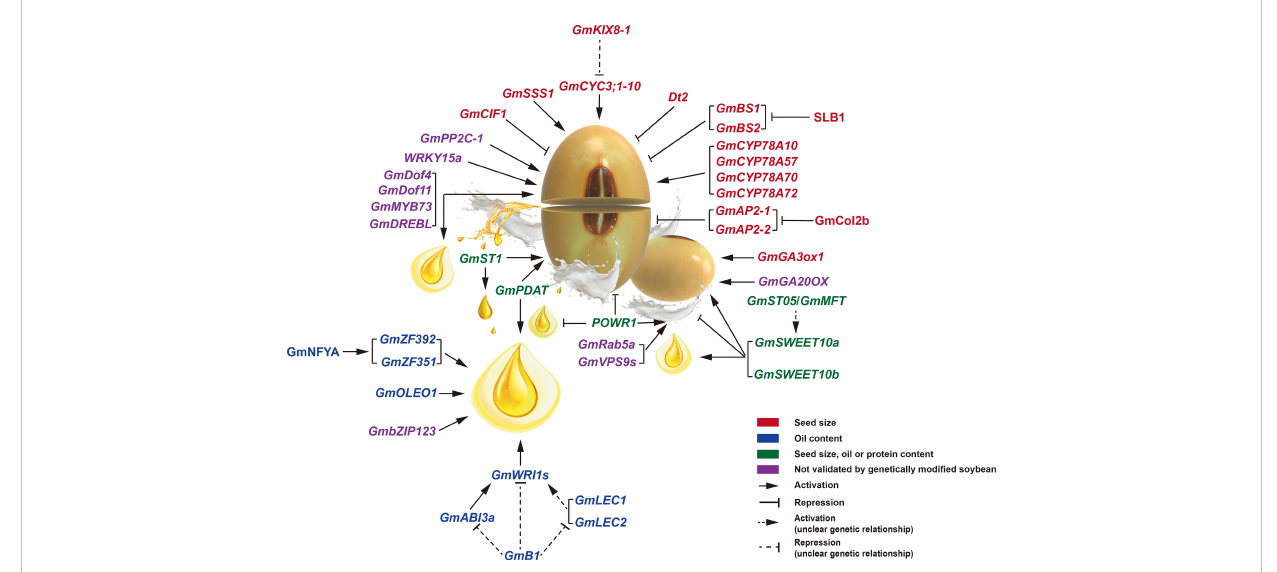
FIGURE 3 Genetic regulatory network of seed size (weight), oil accumulation, and protein content in soybean. The genes or proteins involving seed size (weight) and oil content are shown in red and blue fonts, respectively. The pleiotropic regulators for seed size (weight), oil accumulation, or protein content are indicated in green fonts. The regulatory genes, whose function has been validated only in Arabidopsis but not soybean, are shown in purple